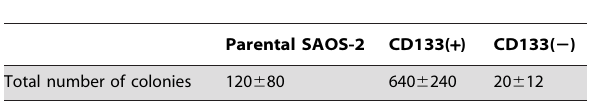
Table 3. Average number of colonies counted 6 standard deviation in 6-well dishes in a triplicate